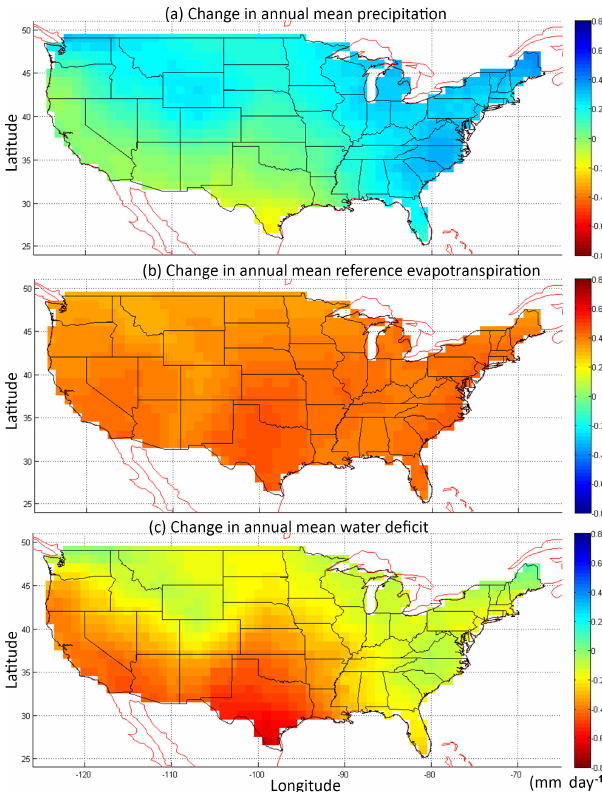
Figure 2. The change in the annual mean (a) P , (b) ET 0 , and (c) P – ET 0 over the US. All units are mmday − 1 and the change is defined as the mean of 2070–2100 minus that of 1950–2005. These changes are averaged over all GCMs, ET 0 estimation methods, and RCP trajectories.